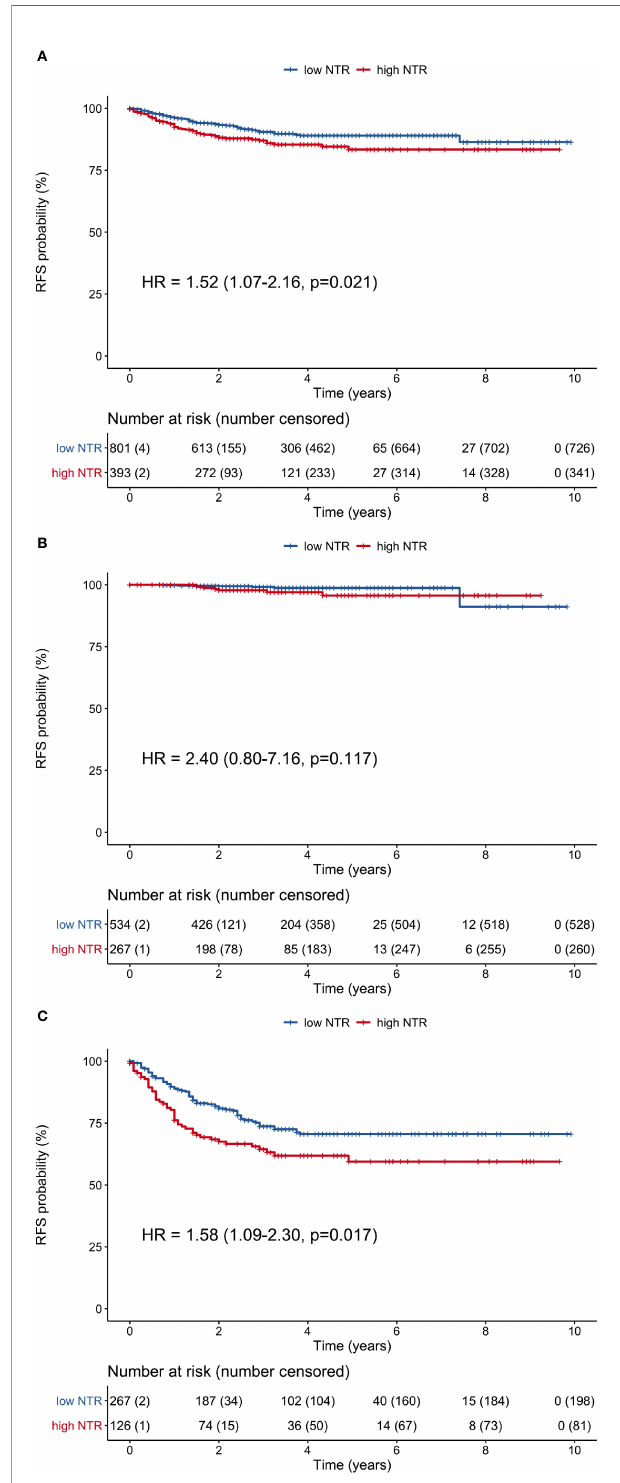
FIGURE 5 | Recurrence-free survival curves of patients grouped according to low or high 1-month neutrophil count. (A) all patients, (B) stage I patients, (C) stage II/III patients. (HR, hazard ratio; NTR, neutrophil; RFS, recurrence- free